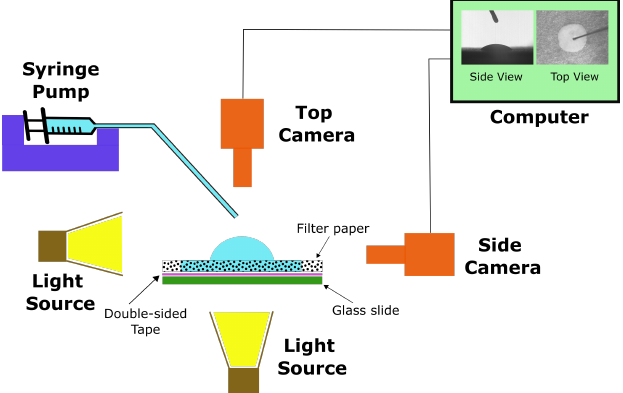
Figure 6. Sketch of the experimental setup used for the droplet spreading